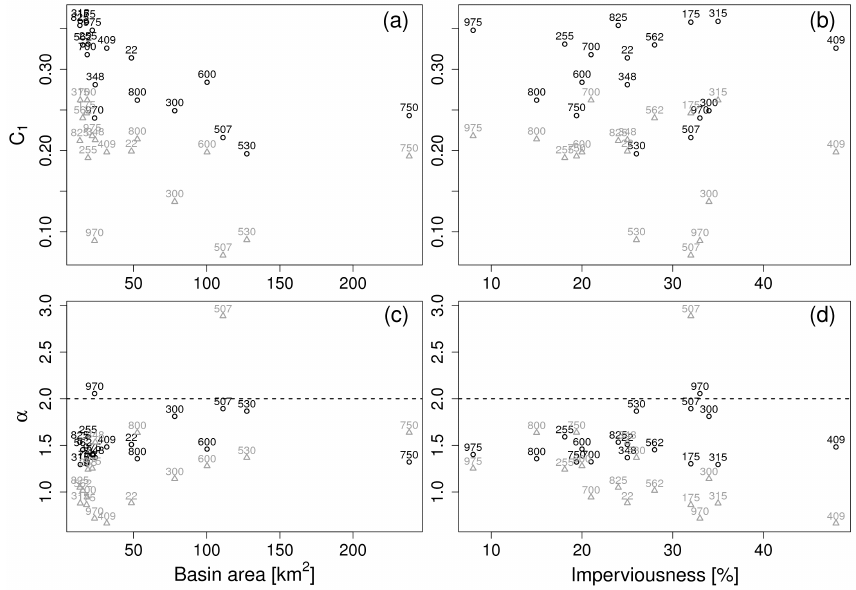
Figure 12. Multifractal parameters C 1 and alpha for scaling analysis of flows and inter-amount times, as a function of drainage area and imperviousness degree. Grey triangle symbols represent inter-amount times, black circles represent